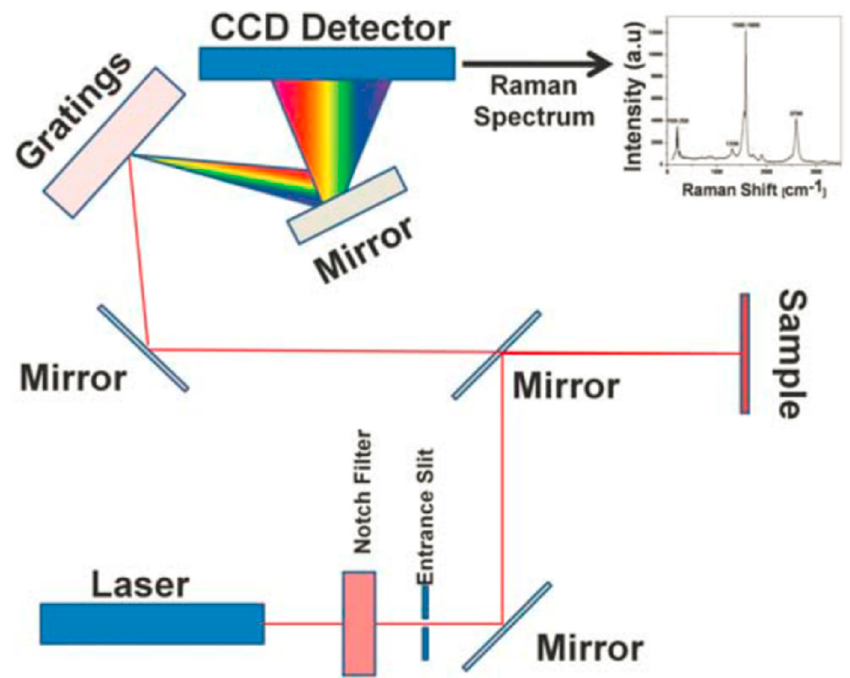
Figure 10. Schematic diagram of the Raman system. Adapted from [111], with permission from © 2017 Elsevier.